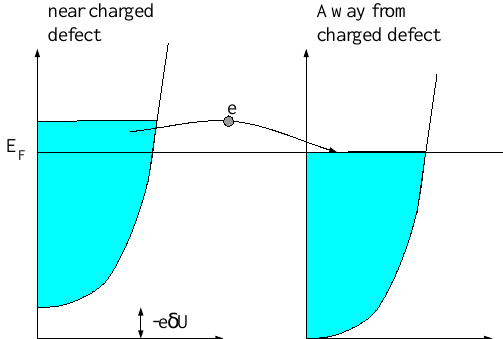
Figure 8. The shift in the DOS parabola near a charged defect causes electrons to move away from the